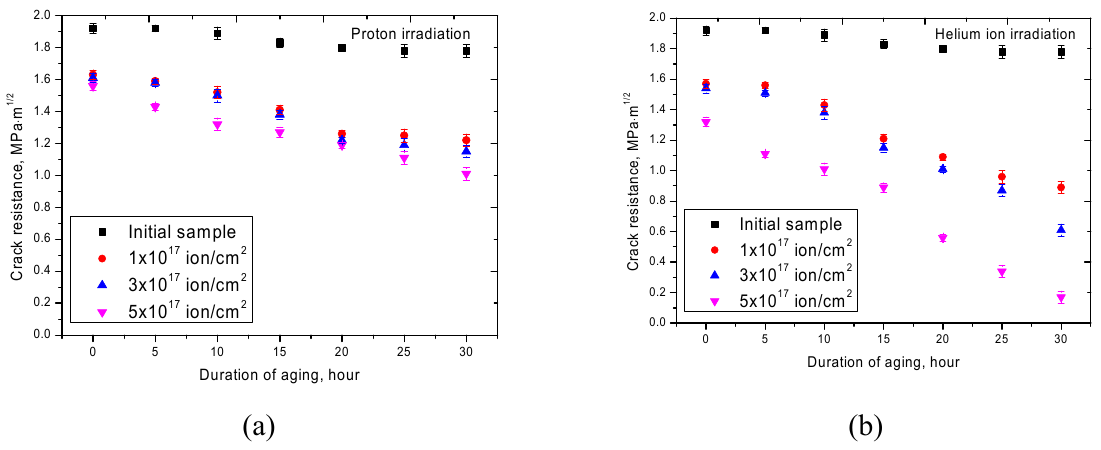
Figure 6. Graphs of the dependence of the crack resistance on the aging time of the samples: ( a ) proton irradiation; ( b ) helium ion irradiation.